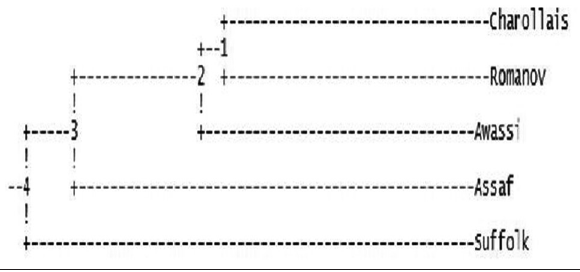
Figure-1: Unweighted pair group method with arithmetic mean dendrogram among Romanov, Charollais, and Suffolk, Awassi, and Assaf sheep